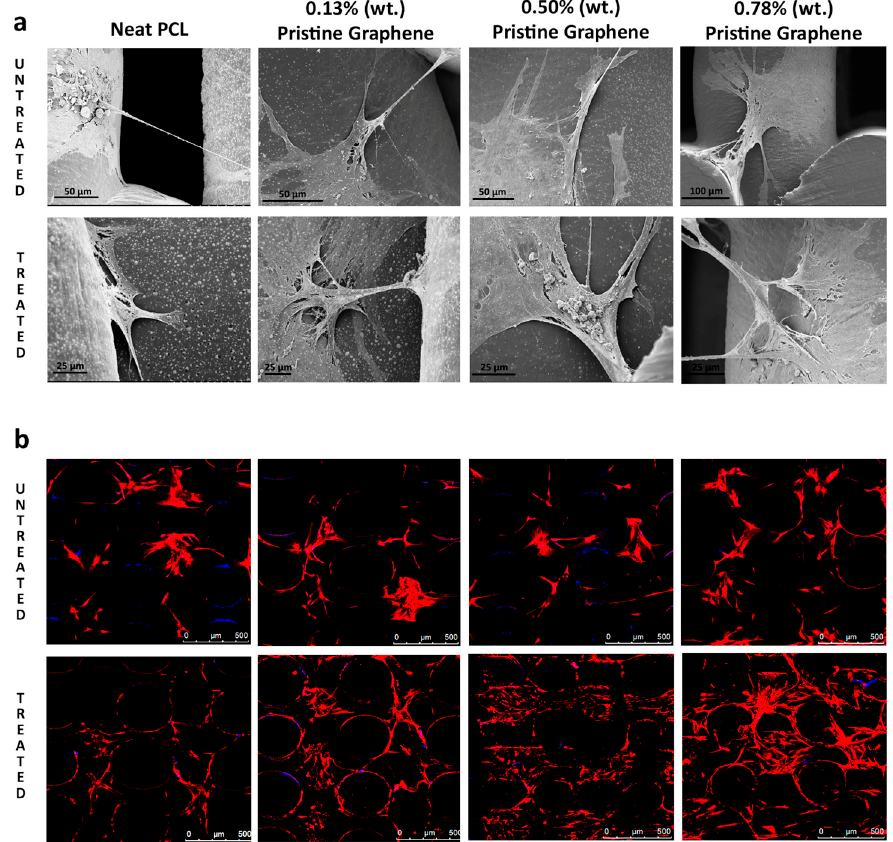
Figure 2. Proliferation and cell viability of human adipose derived stem cells on Polycaprolactone (PCL) and pristine graphene scaffolds ( a ) SEM images after 21 days culture; and, ( b ) confocal images after 28 days culture [64] (copyright 2016, Materials).